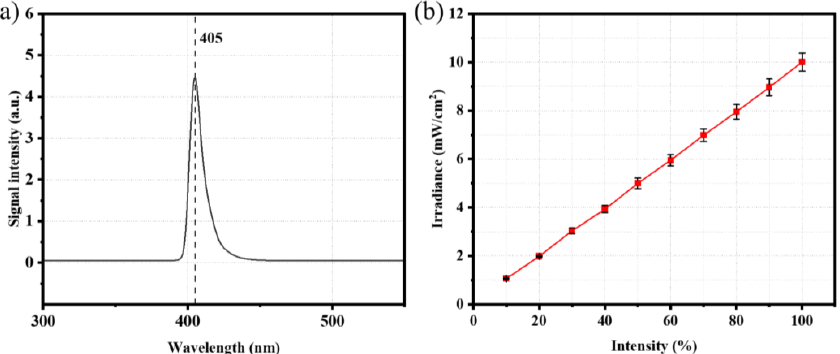
Figure 2. UV light characteristics of DLP printer: ( a ) radiation spectrum of the source, ( b ) irradiance at different light intensities (grayscale).